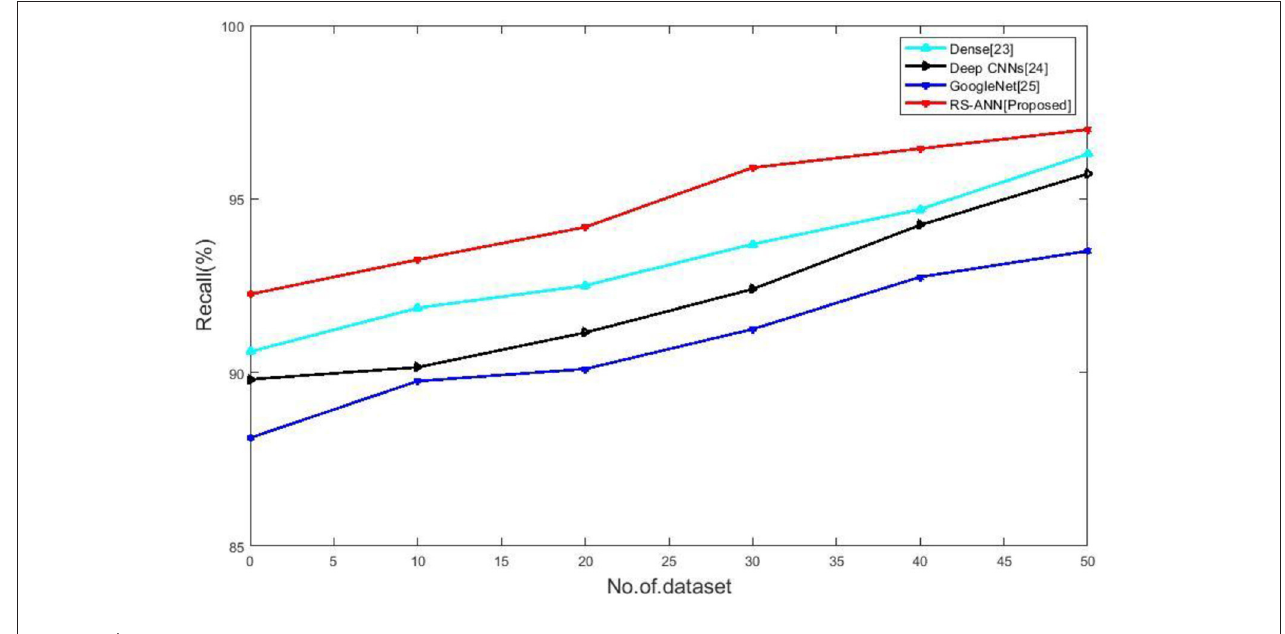
FIGURE 5 | No of dataset vs. recall.